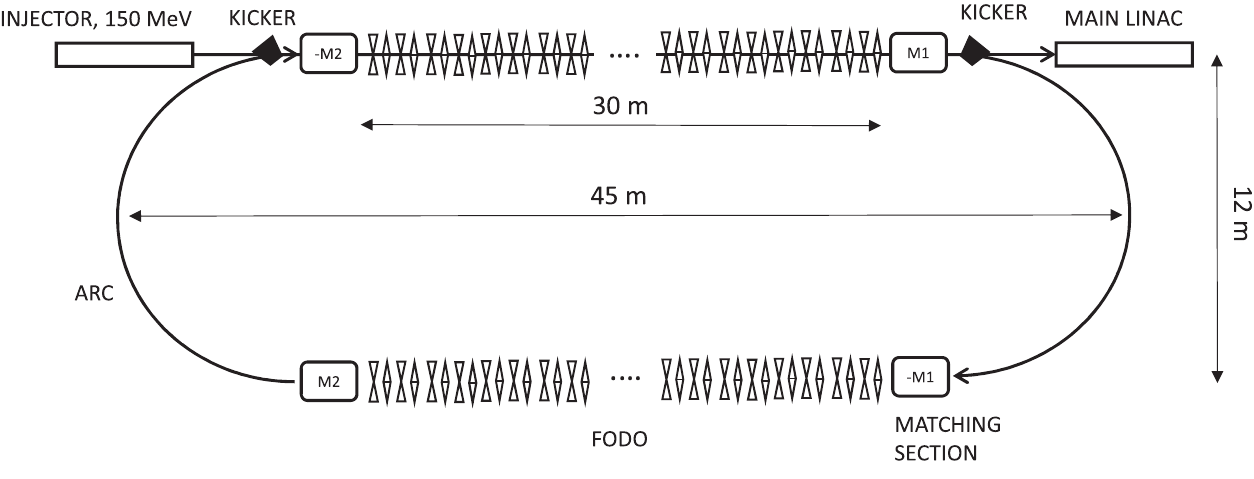
FIG. 5. Schematic layout of the recirculating IBS beam line (not to